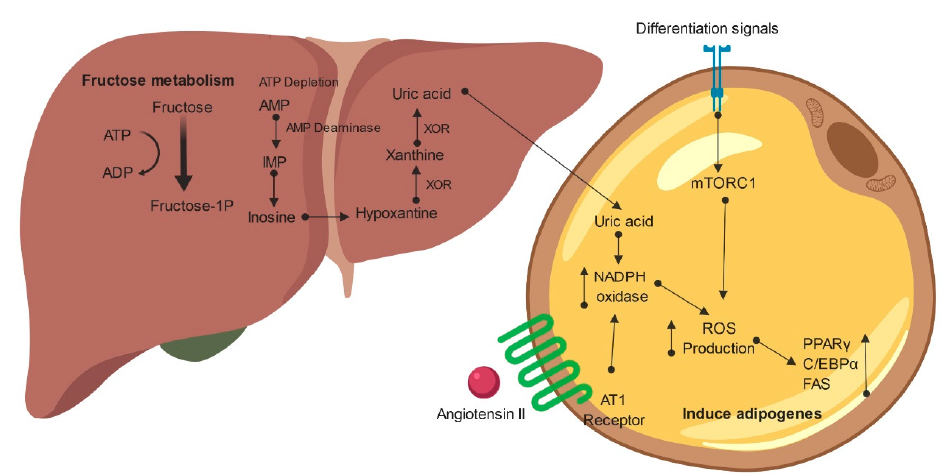
Figure 3. Fructose-induced reactive oxygen species (ROS) production promotes adipogenesis. Fructose metabolism induces adipogenesis through increasing ROS production. ROS may be induced by uric acid, NADPH oxidase activity, mTORC1 signaling and AT1 receptor signaling. ROS: Reactive oxygen species; NADPH: Nicotinamide adenosine dinucleotide phosphate; XOR: Xanthine oxidase; FAS: Fatty acid synthase; C/EBP α : CCAAT-enhancer-binding protein α ; PPAR ϒ : Peroxisome proliferator-activated receptor ϒ . Created with Biorender.com.